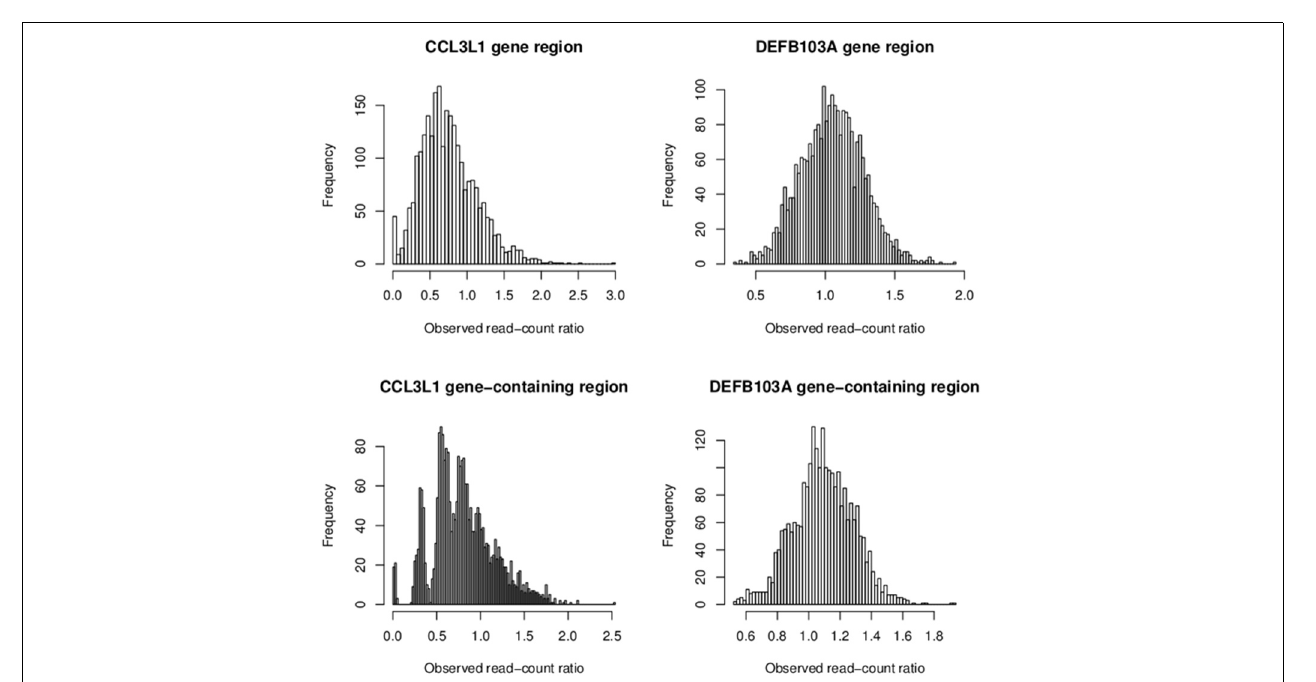
FIGURE 10 | Observed read-count ratios of samples at the CCL3L1/DEFB103A gene (medians: 0.7 and 1 respectively) and the CCL3L1 /DEFB103A-containing region (medians: 0.8 and 1 respectively).